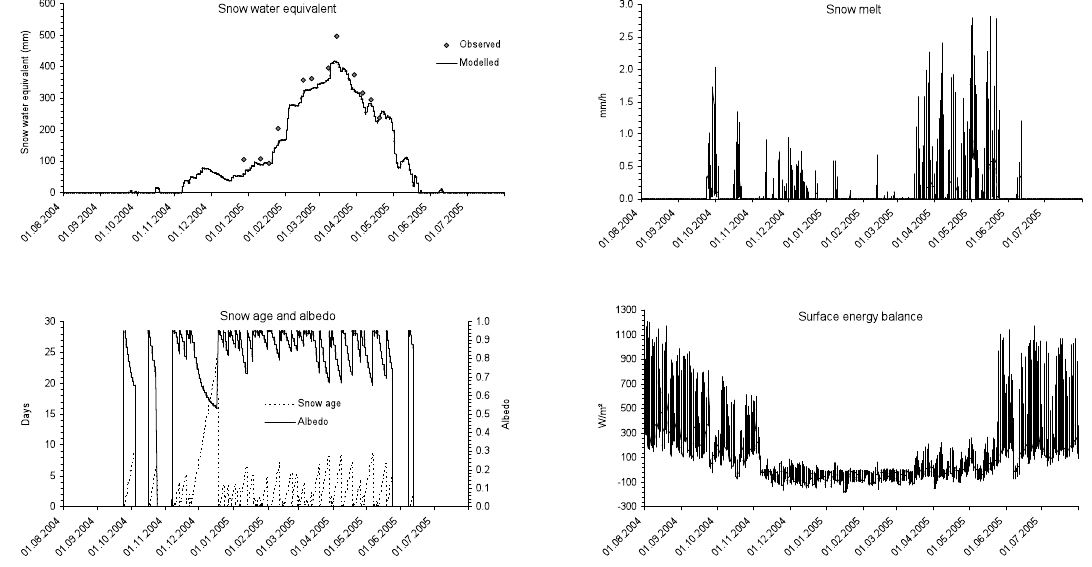
Fig. 4. Results of the ESCIMO.spread model run for the example data. Fig 4. Results of the ESCIMO.spread model run for the example data. 3